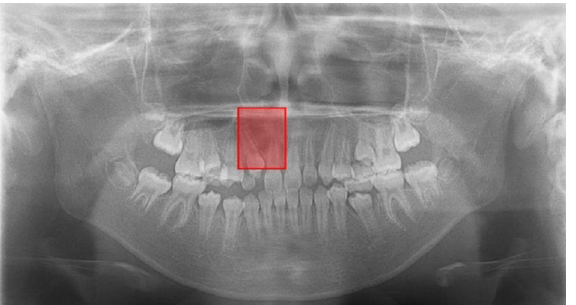
Figure 6. A falsely detected normal case. In a normal subject (without CA), a red bounding box is shown on the right incisor region. The inferior piriform aperture lines on the both sides are obscure and superimposed by the radiopaque lines caused by the hard palate. The right lateral incisor is missing (probably congenitally), and the canine shows medial inclination, so the space between these teeth is relatively wide. The model probably mistakenly recognizes the canine as the lateral incisor.